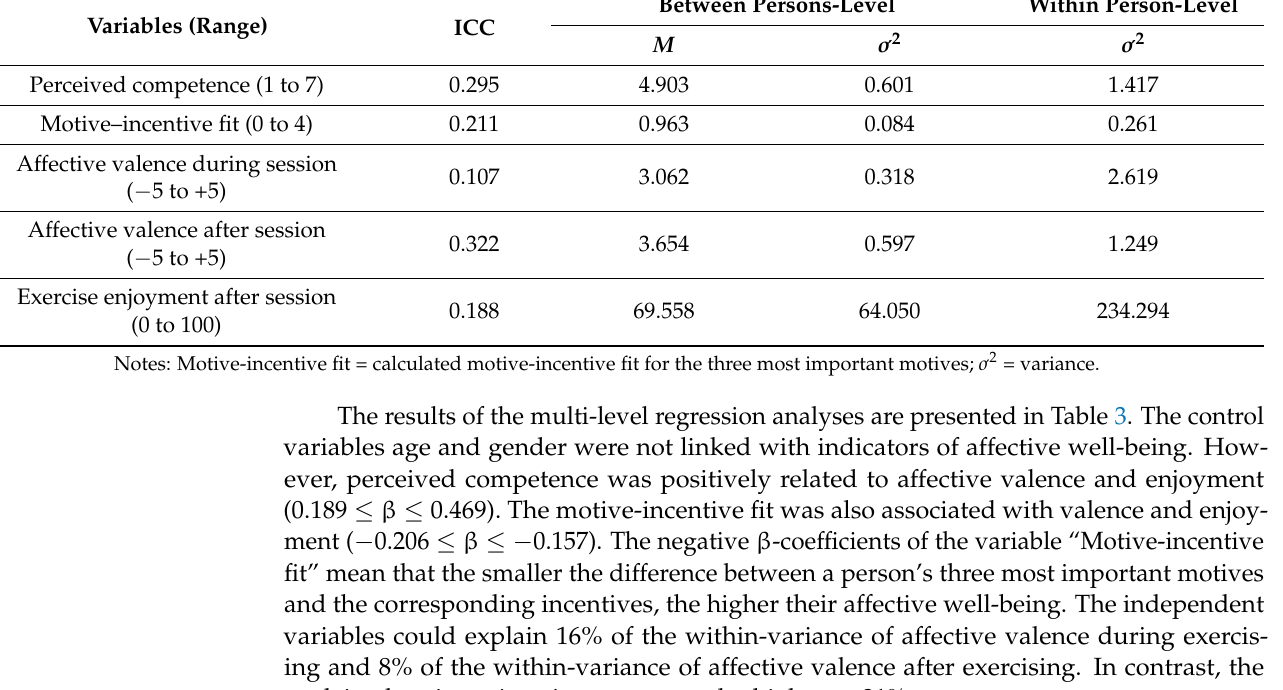
Table 2. Descriptives of the time-varying variables: Intraclass correlation coefficients, means, and variance components. Variables (Range)